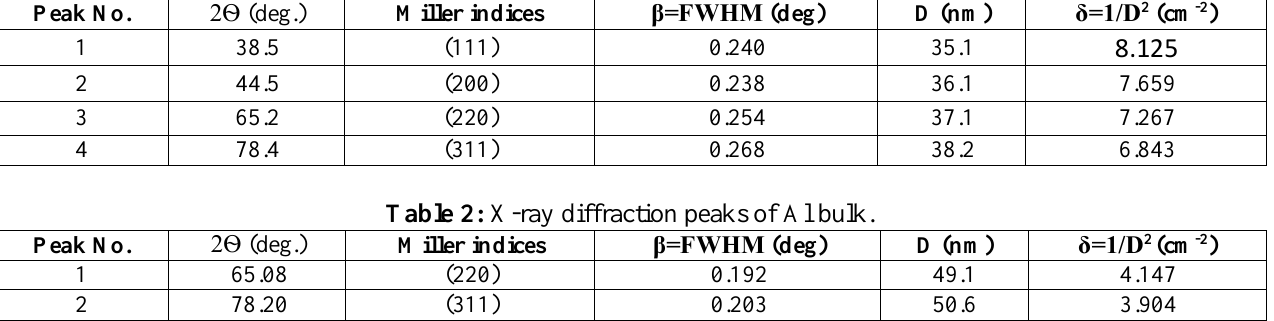
Table 1: X-ray diffraction peaks of Al NPs. The data are approximated to three significant figures. Peak No.